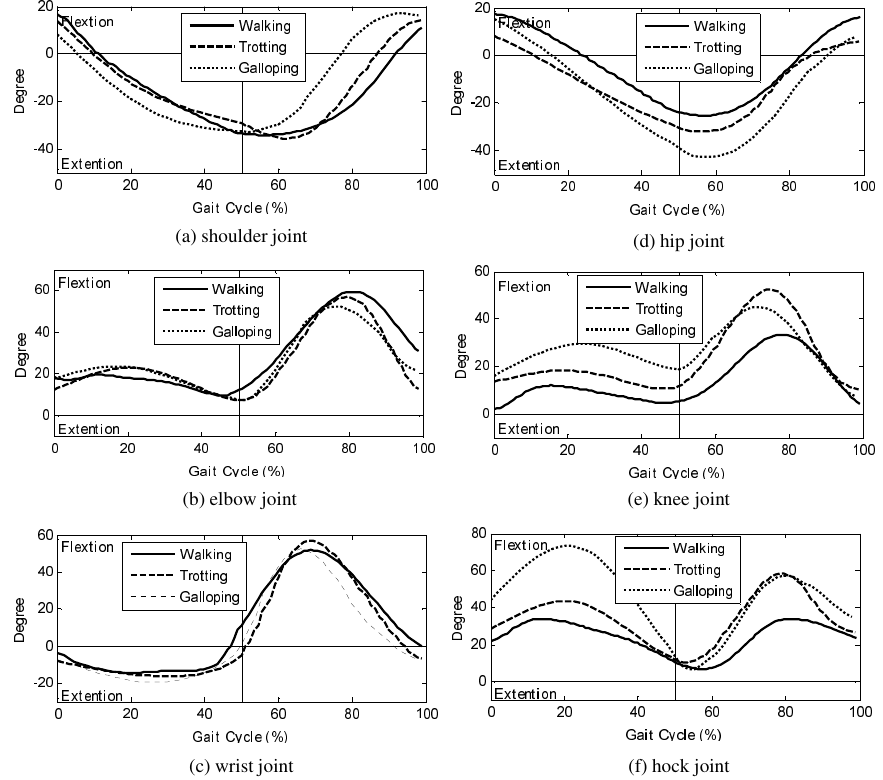
Figure 4. Joint-angle trajectories over scaled gait cycles: ( a ) the shoulder joint-angle, ( b ) the elbow joint-angle, ( c ) the wrist joint-angle, ( d ) the hip joint-angle, ( e ) the knee joint-angle, and ( f ) the hock